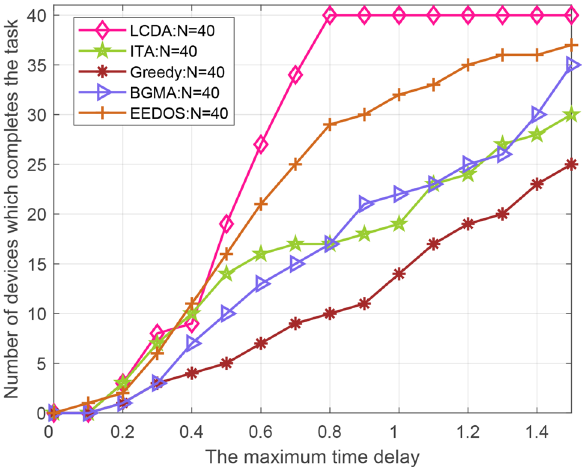
Figure 11. The number of devices that can complete the task versus Maximum delay of different modes (N = 40).